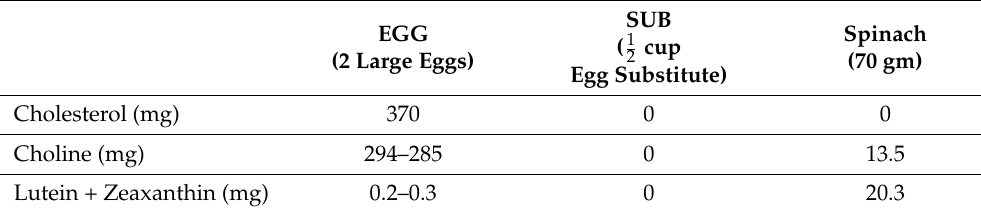
Table 1. Daily intake of cholesterol, choline and lutein + zeaxanthin content in eggs, egg substitute (SUB) and